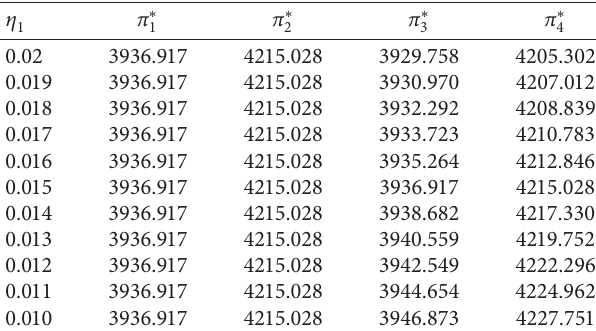
Table 4: Impact of the deterioration rate on the optimal